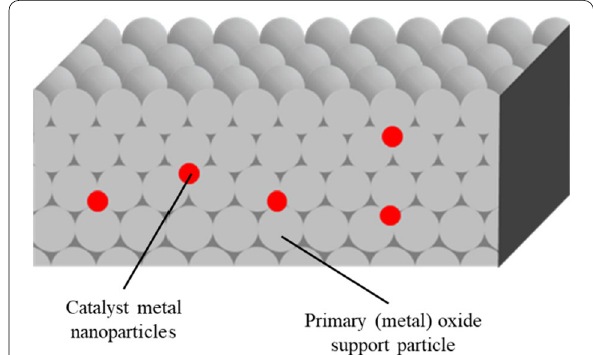
Fig. 1 Schematic of embedded nanometal in gaps of primary (metal) oxide support